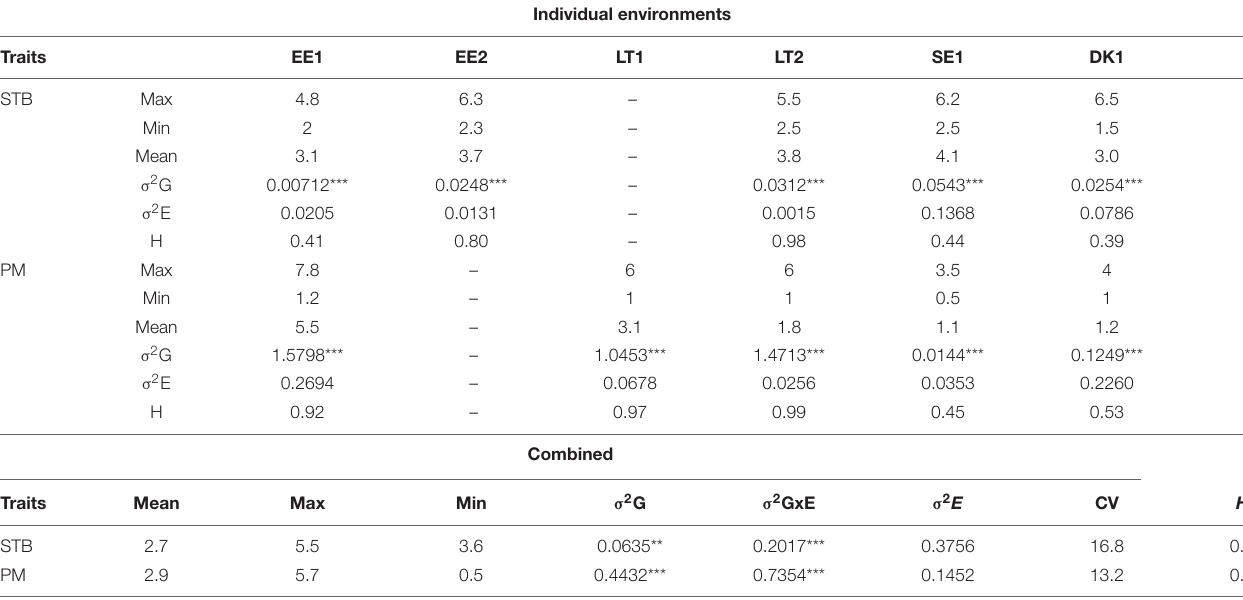
TABLE 1 | Analysis of variance and heritability for the two disease scores across and combined